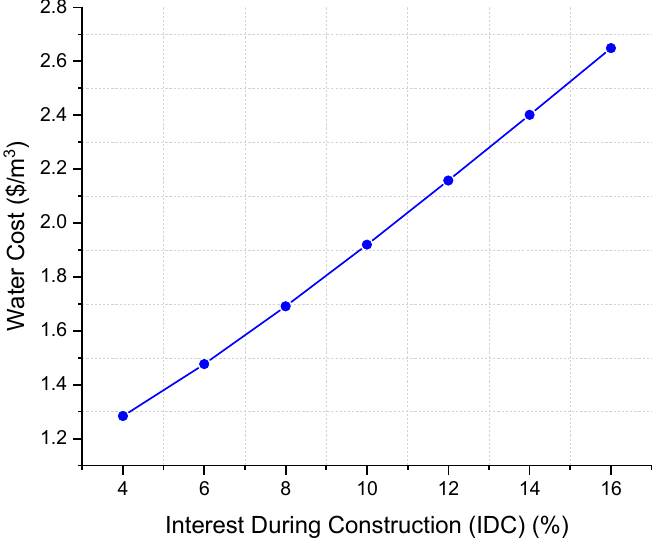
Figure 7. Sensitivity analysis of water cost (USD/m 3 ) versus IDC (%).